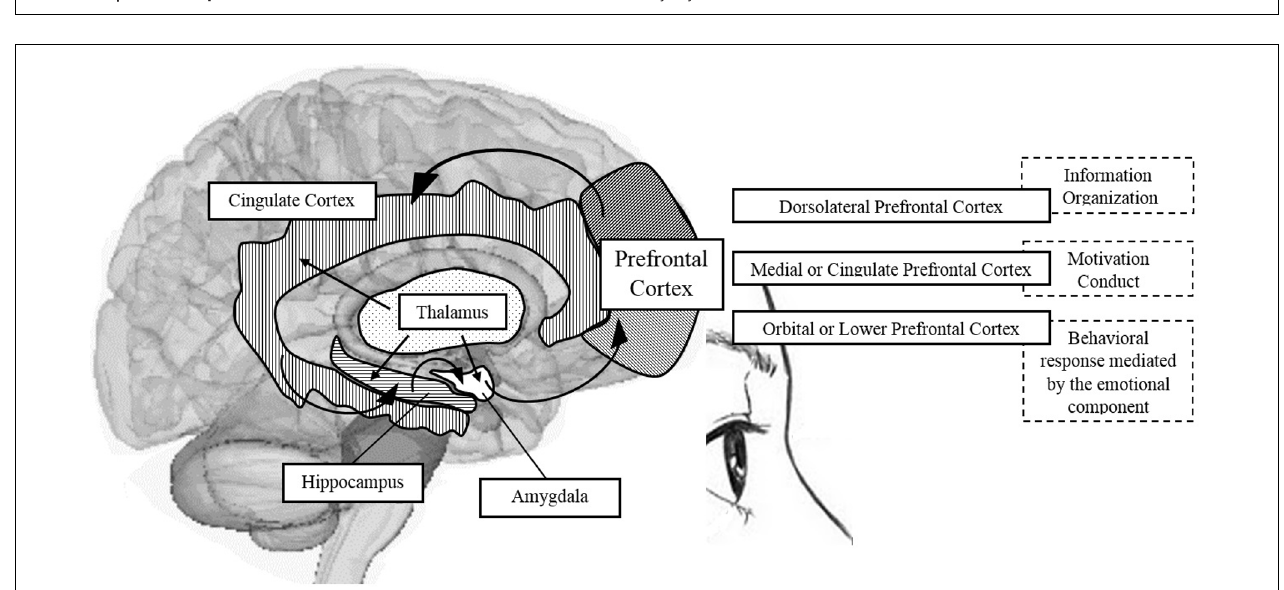
FIGURE 1 | Main components and characteristics of the EFs. Source: made by myself.